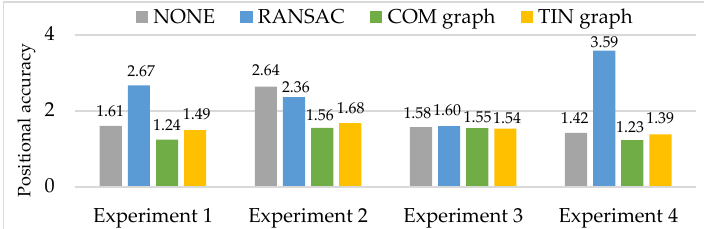
Figure 11. Experimental results of positional accuracy (RMSE, pixel).